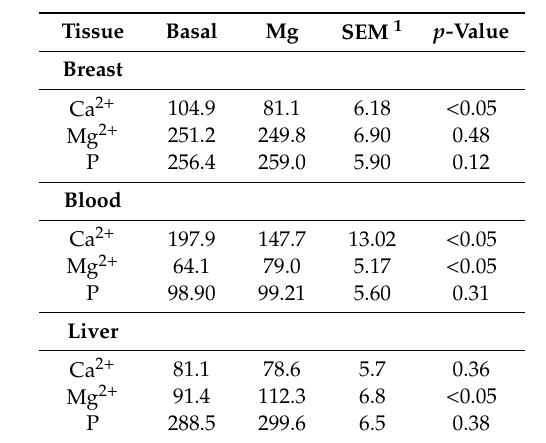
Table 3. E ff ect of the dietary treatment on the concentration of Mg 2 + , Ca 2 + and P (mg / kg) in breast, blood and liver of experimental broilers.